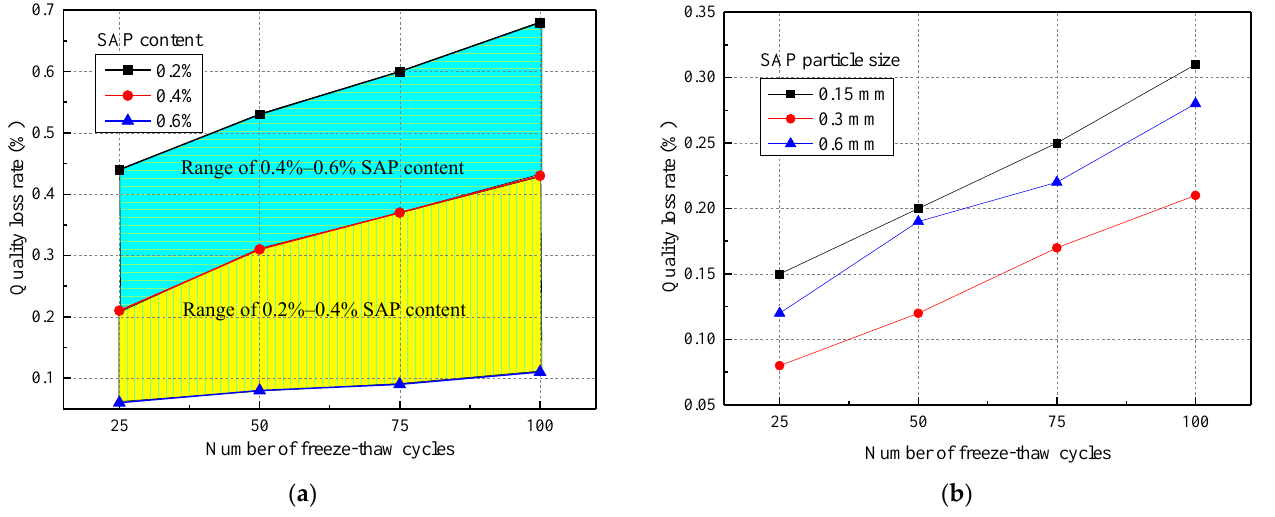
Figure 14. Effect of SAP on concrete mass loss rate: ( a ) SAP particle size of 0.3 mm; ( b ) SAP content of 0.4%.